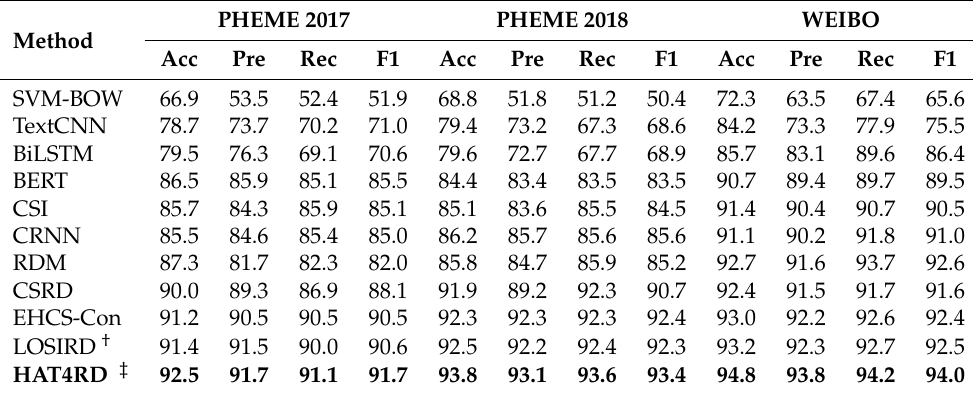
Table 2. The results of different methods on three datasets. We report their average of five runs. Method